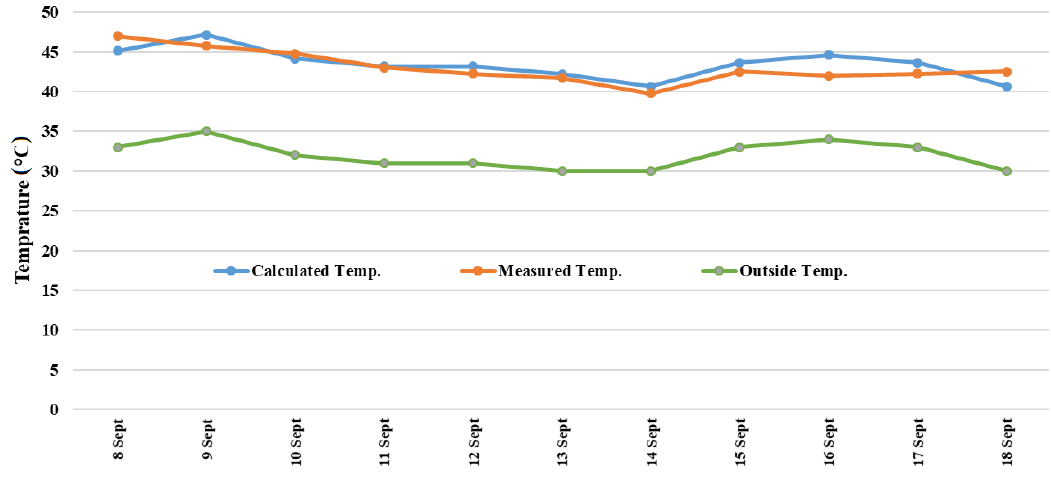
Figure 4. Emissivity values before and after absorbing the (low-emissivity) coating.